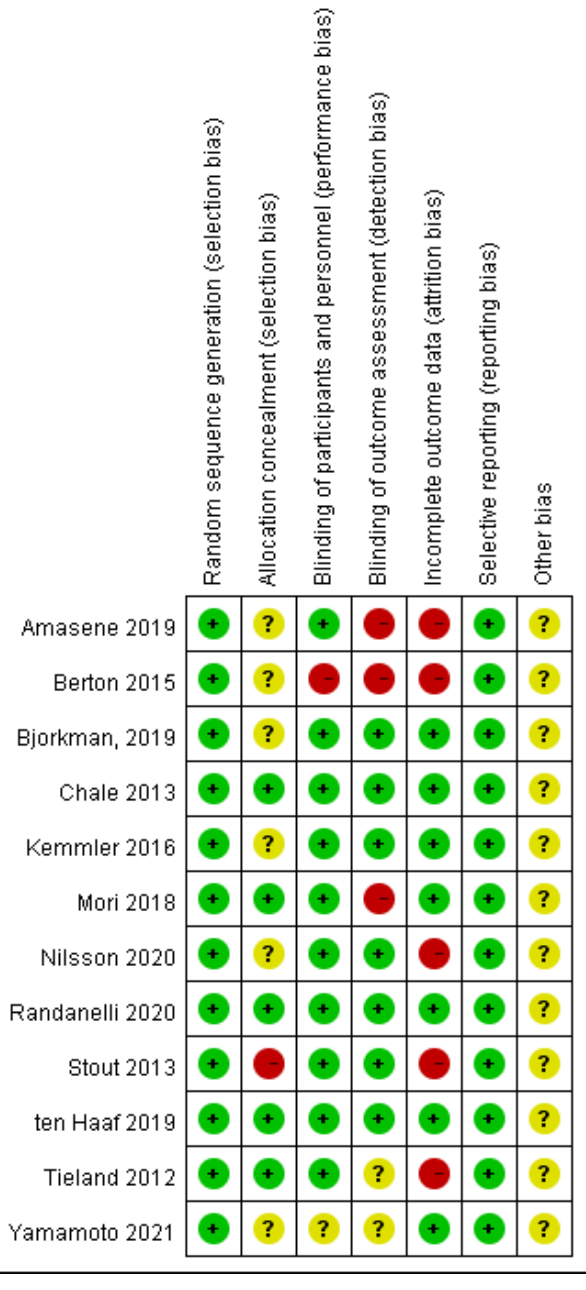
Figure 2. Risk-of-bias assessments for the selected studies.